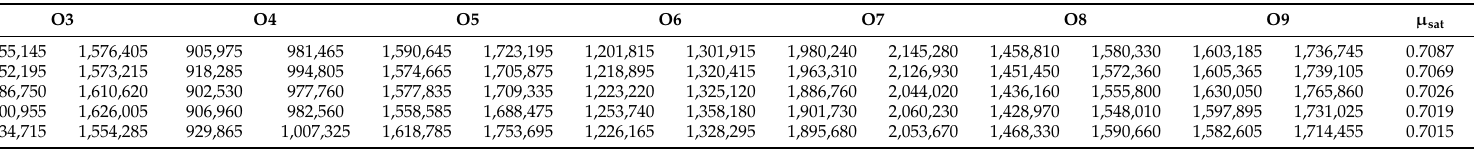
Table 7. Best ranked solutions to Problem 1 with N sat = 10 and N dis = 0 (after the consensus